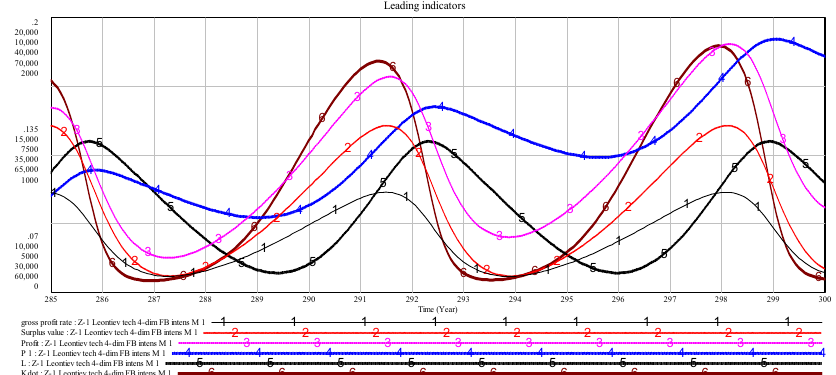
Fig. 10 Leading, coinciding and lagging indicators of industrial cycles resulting from the first AHB in L-2: profit rate (1), investment (6), surplus value (2), profit (3), net output (4) and employment (5), years 285–230